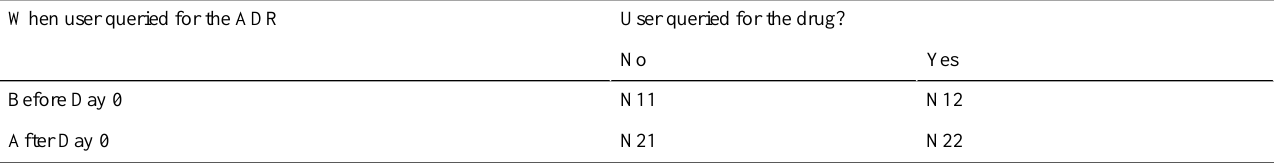
User queried for the drug?When user queried for the ADR YesNo